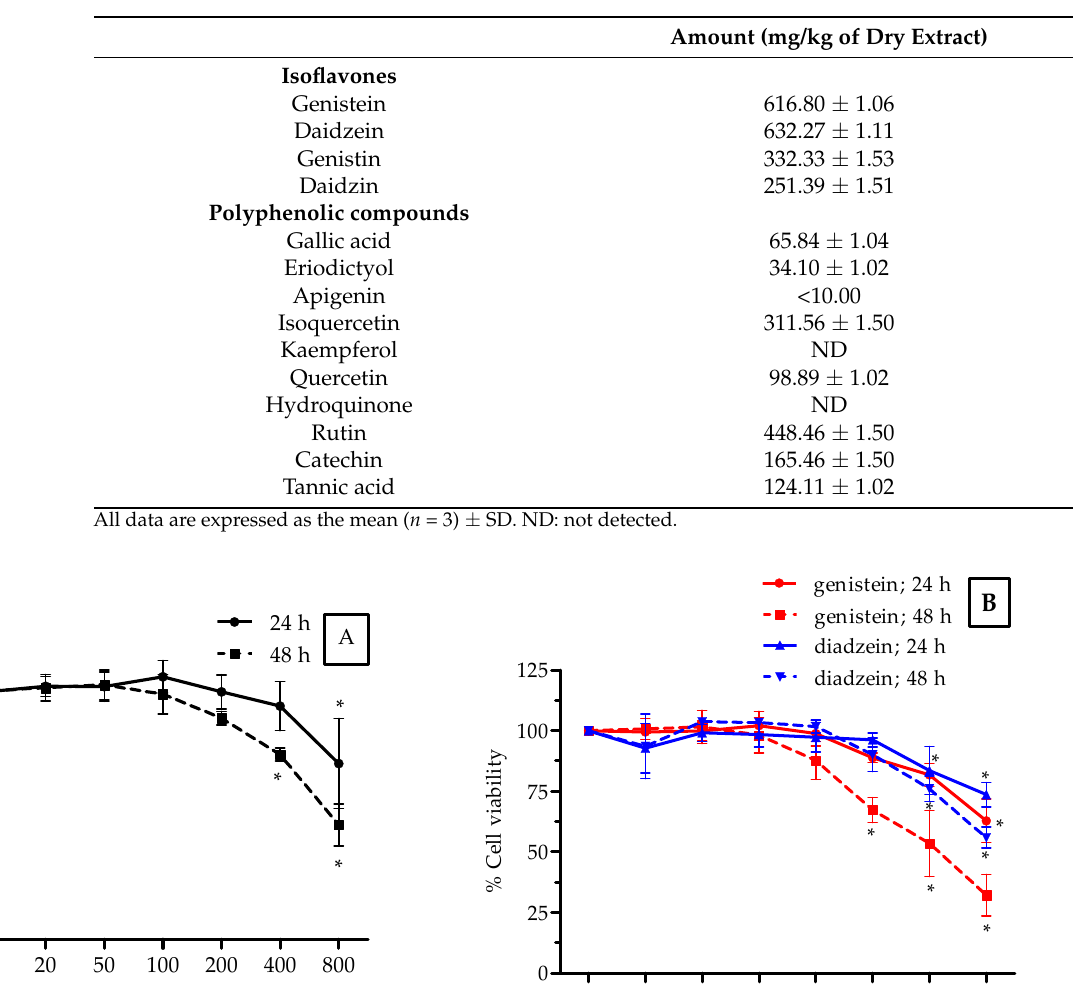
Table 2. The contents of the isoflavones and polyphenolic compounds of the ethanolic isoflavone extracts from Thua-nao.